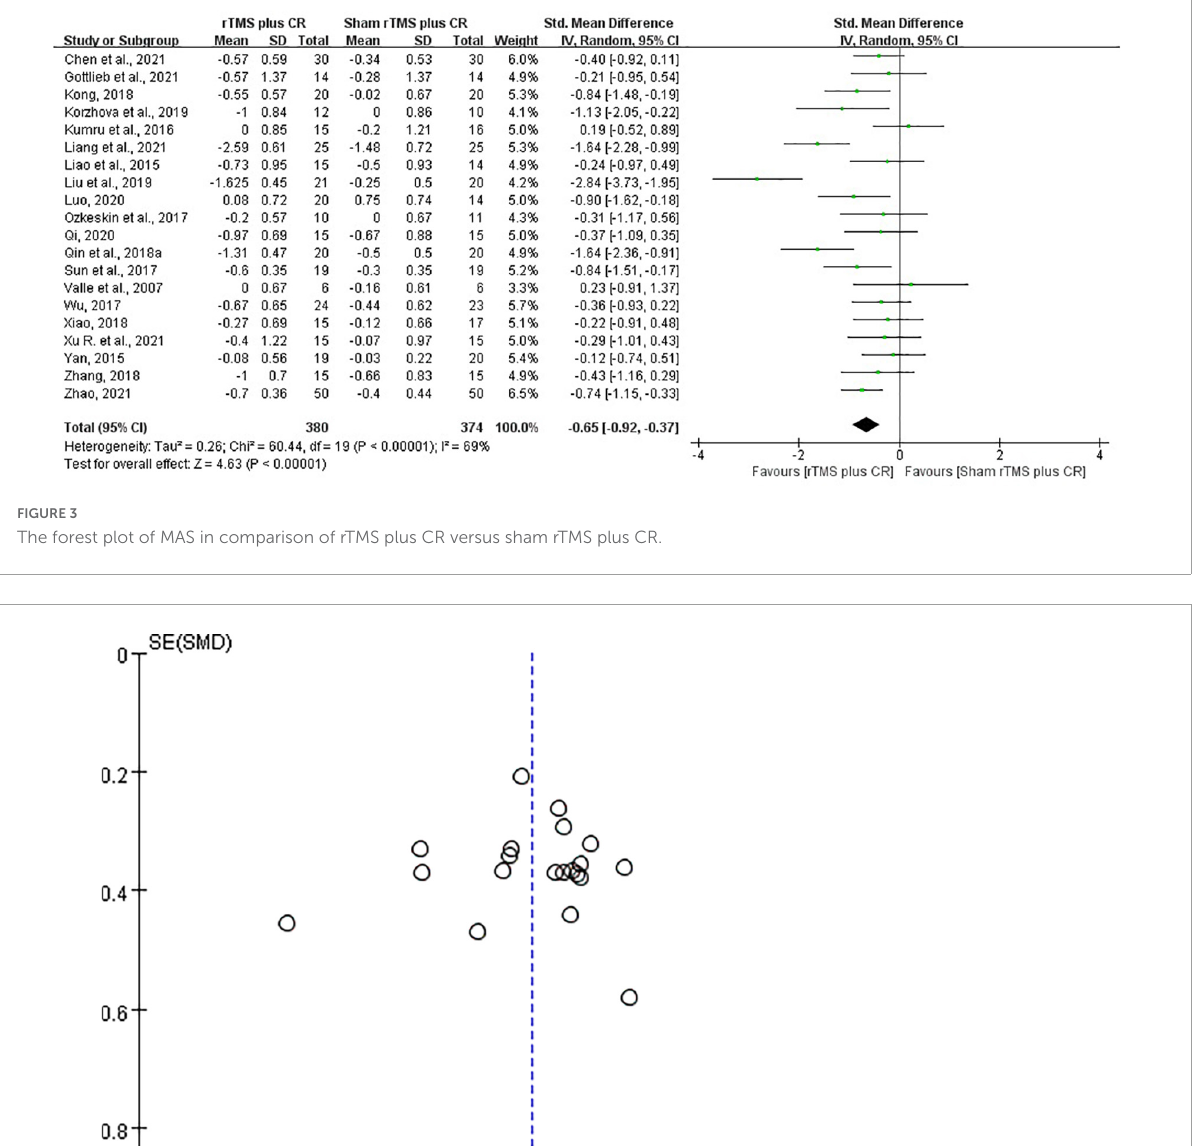
( Figure 7 ). No publication bias was detected based on the Egger’s test ( P = 0.449) and Begg’s test ( P = 1.000).